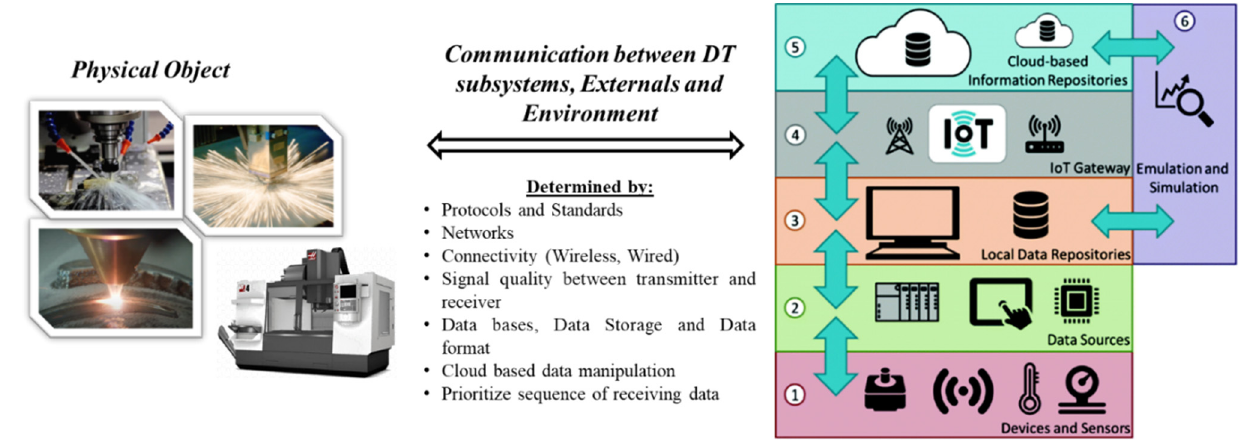
Figure 8. Signal processing techniques and signatures phenomena [93–96].